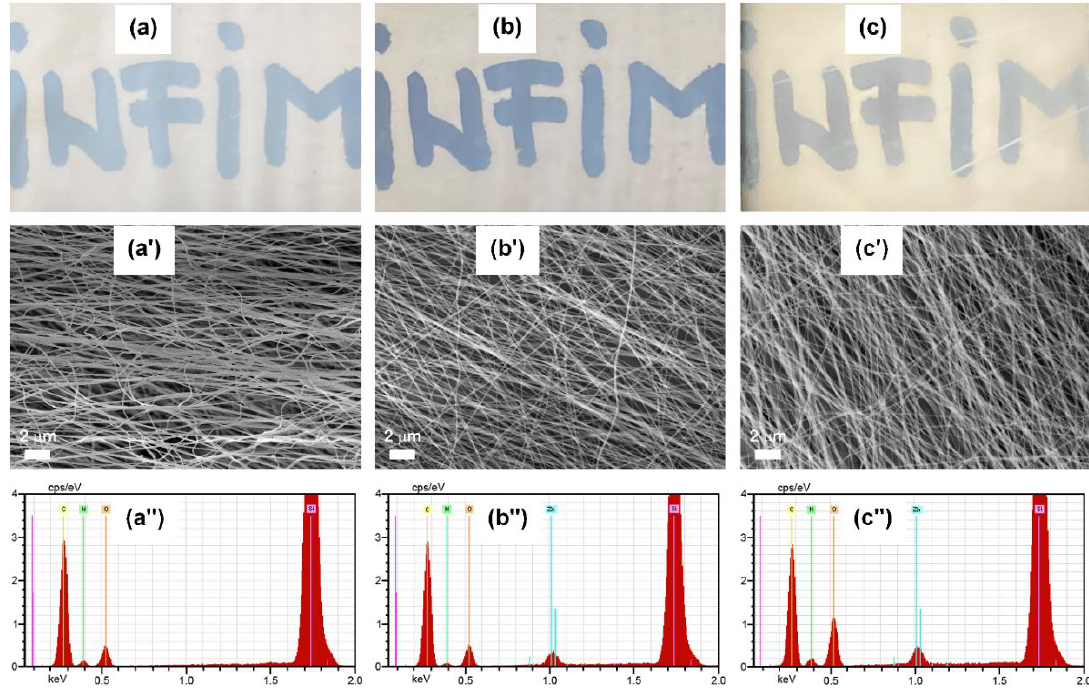
Figure 1. Photographs, FESEM images and energy dispersive X-ray analysis (EDX) spectra of ( a , a’ , a” ) nylon, ( b , b’ , b” ) nylon-ZnO and ( c , c’ , c” ) nylon-ZnO / PPy, respectively. Nanomaterials 2020 , 10 , x FOR PEER REVIEW